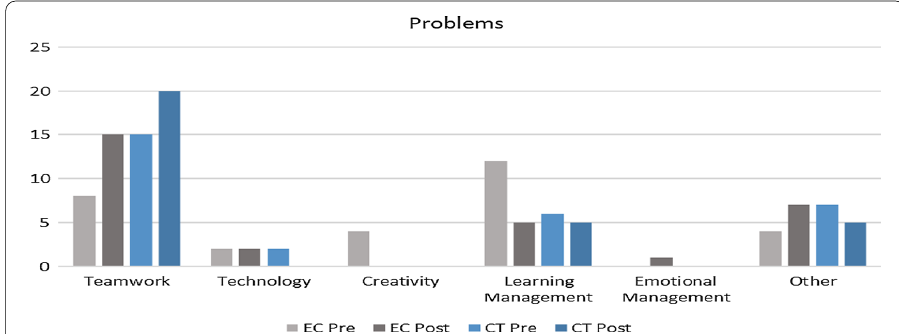
Fig. 9 Graphical representation of issues faced as a team